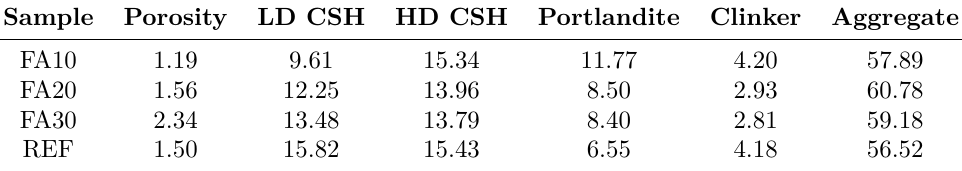
Table 4. Percentage representation of individual phases in composite